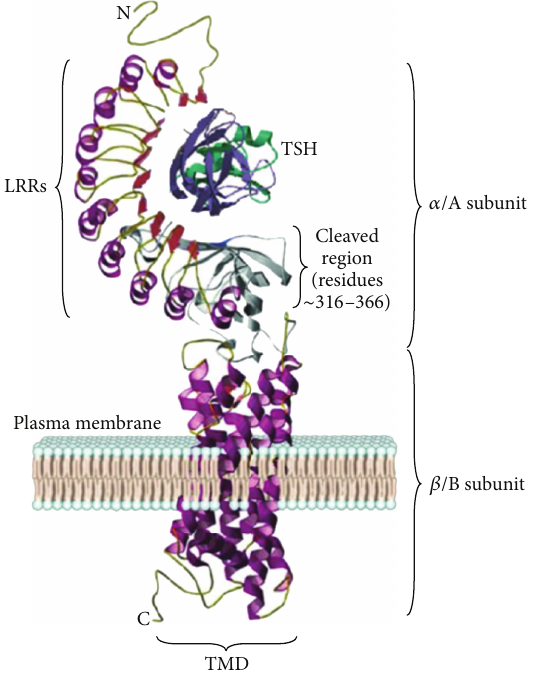
Figure4:TSHReceptorStructure. TheTSHRincludesalargeextra- cellular domain ( 𝛼 or A subunit) that includes nine leucine-rich repeat (LRR) domains and transmembrane/intracellular domain (b- or B subunit). Adapted from